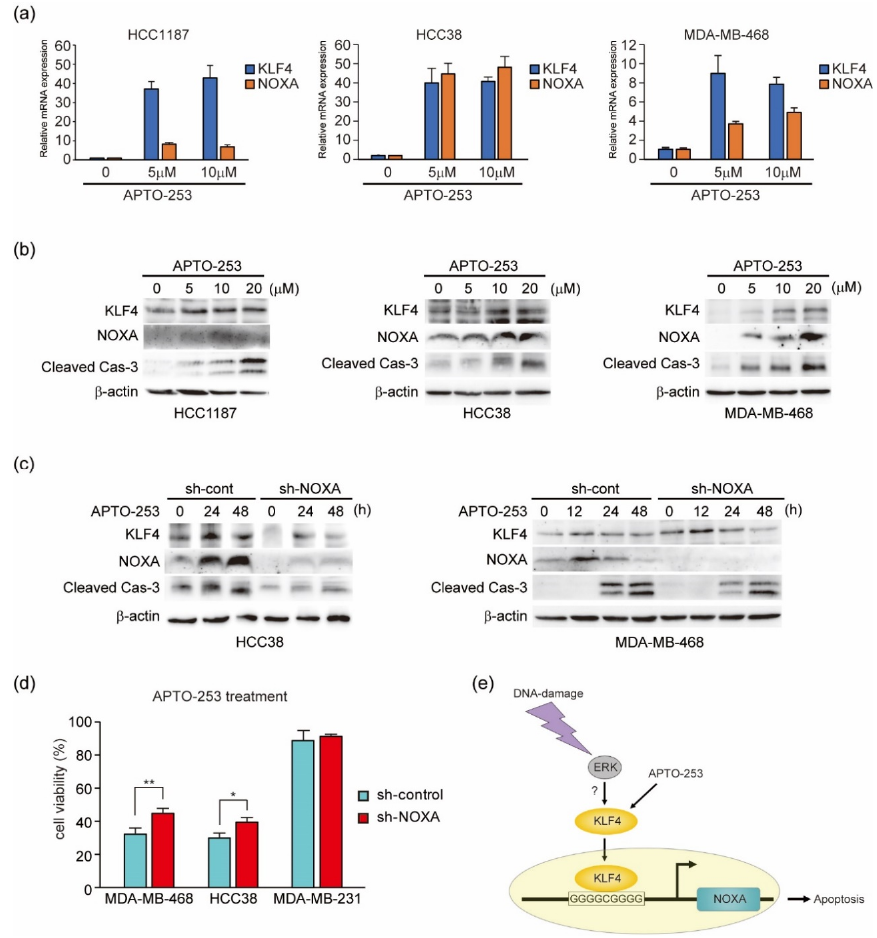
Figure 8. APTO-253 promotes KLF4 mRNA expression and induces NOXA-mediated apoptosis in TNBC cell lines with low KLF4 expression. ( a , b ) Cells were exposed to the indicated amounts of APTO-253 (5–20 µ M). After 24 h of treatment, the indicated mRNA expression levels in MBA-MB- 468 ( left ), HCC38 ( middle ) and HCC1187 ( right ) cells were measured by qPCR ( a ), and 20 µ g of total cell lysates was subjected to immunoblot analysis with the indicated antibodies ( b ). Quantitative analysis of immunoblot results is shown in Supplementary Figure S6a. ( c , d ) HCC38, MDA-MB-468 or MDA-MB-231 cells stably expressing shRNA-targeting NOXA (sh-NOXA) or sh-control were treated with APTO-253 (5 µ M). After the indicated treatment time, MDA-MB-231 and HCC38 cells were analyzed by immunoblot analysis ( c ). After 24 h of treatment, cell viability was determined by CCK-8 analysis ( d ). Error bars indicate S.E.M. ( n = 3). (* p < 0.05, ** p < 0.01, Welch’s t test; n = 3). Quantitative analysis of immunoblot results is shown in Supplementary Figure S6b. ( e ) Schematic of KLF4-mediated induction of NOXA by DNA-damage or